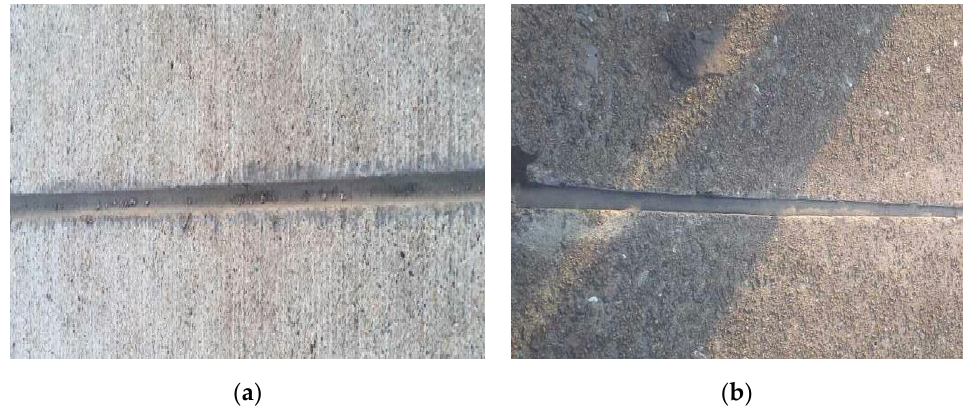
Figure 15. The appearance of the PCFC after 28 days of curing. ( a ) The military airport in Tibet. ( b ) The military airport in Guangdong province.